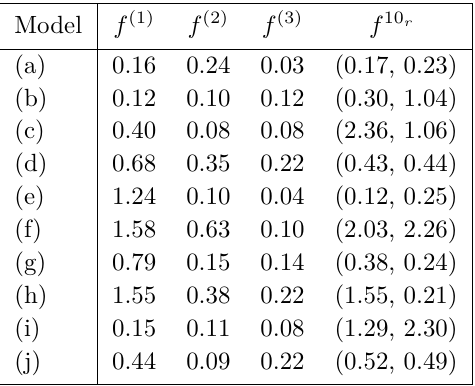
The GUT scale parameters in the cubic and quartic superpotentials W 3 , W (1) and W (3) for the model points (a)–(j). The masses are in 4